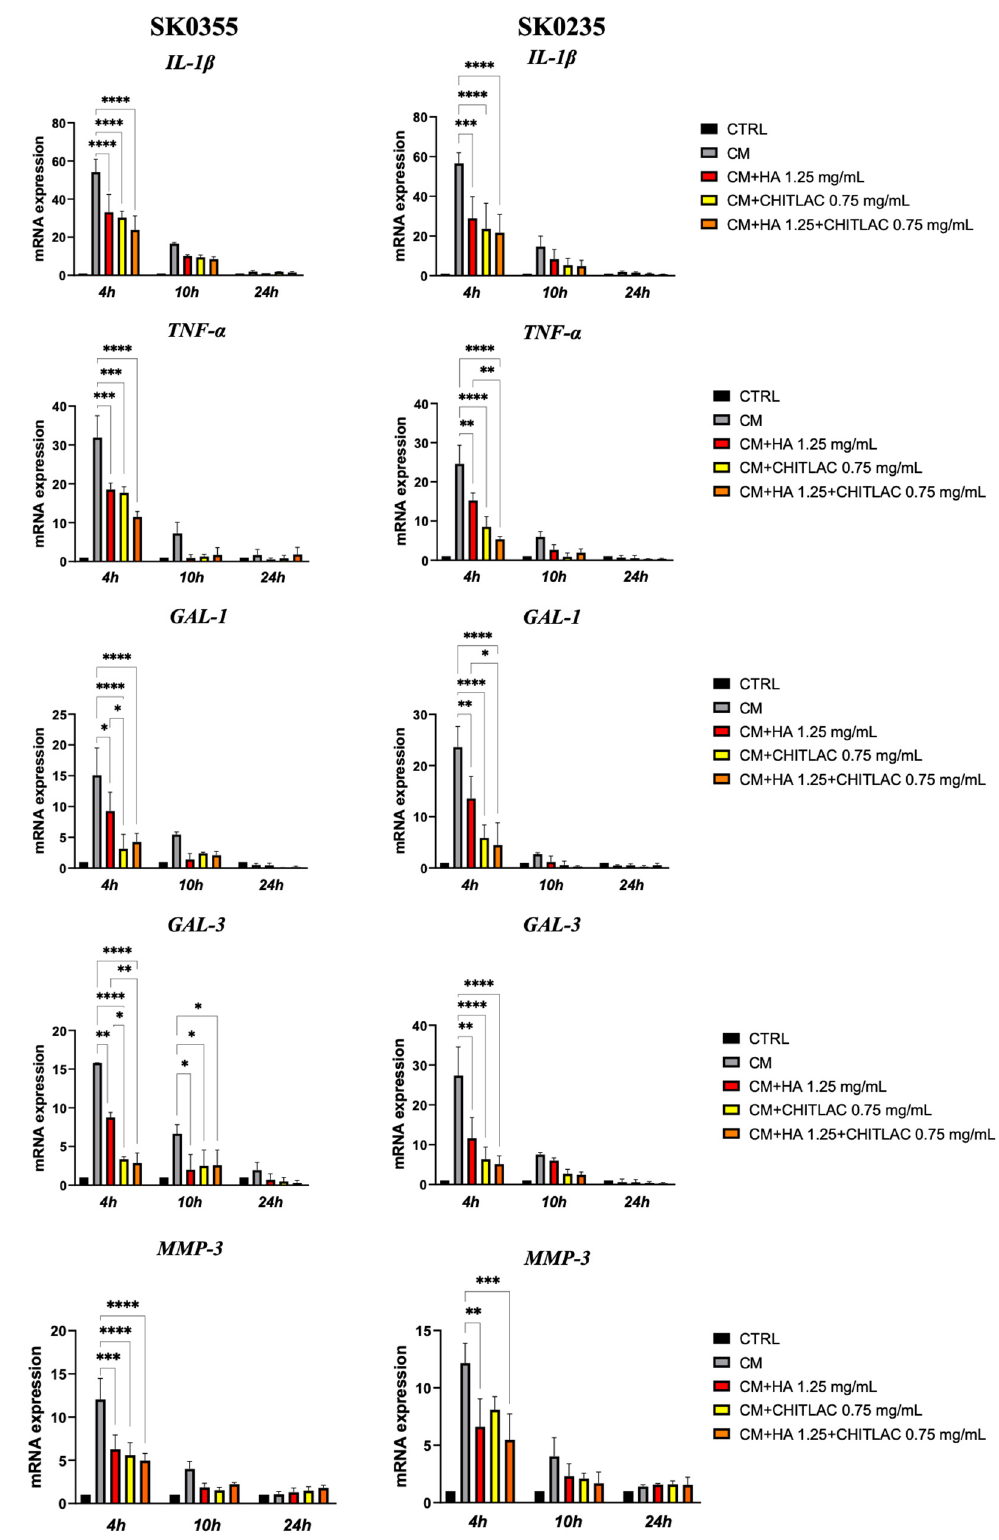
Figure 7. Pro-inflammatory molecule and MMP-3 gene expression in dermal fibroblasts after exposure to U937 CM in the presence or absence of HA, CTL and HA-CTL combination. Human dermal fibroblasts SK0355 (from 30-year-old woman) and SK0235 (from 54-year-old woman) were seeded in 6-well culture dishes and exposed to activated U937 CM for 24 h before being cultured in the presence or absence of 1.25 mg/mL HA, 0.75 mg/mL CTL, or a combination of the two. At 4, 10 and